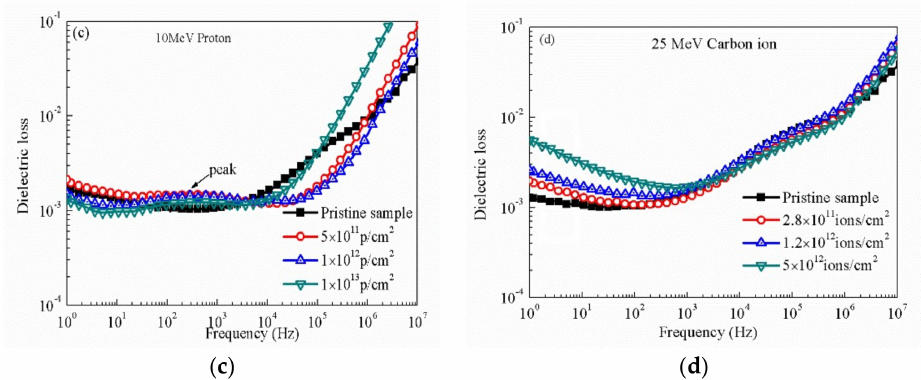
Figure 2. Frequency dependent dielectric loss of pristine and irradiated PI films with di ff erent sources and fluences at room temperature: ( a ) 1 MeV electron, ( b ) 3 MeV proton, ( c ) 10 MeV proton, and ( d ) 25 MeV carbon ion.